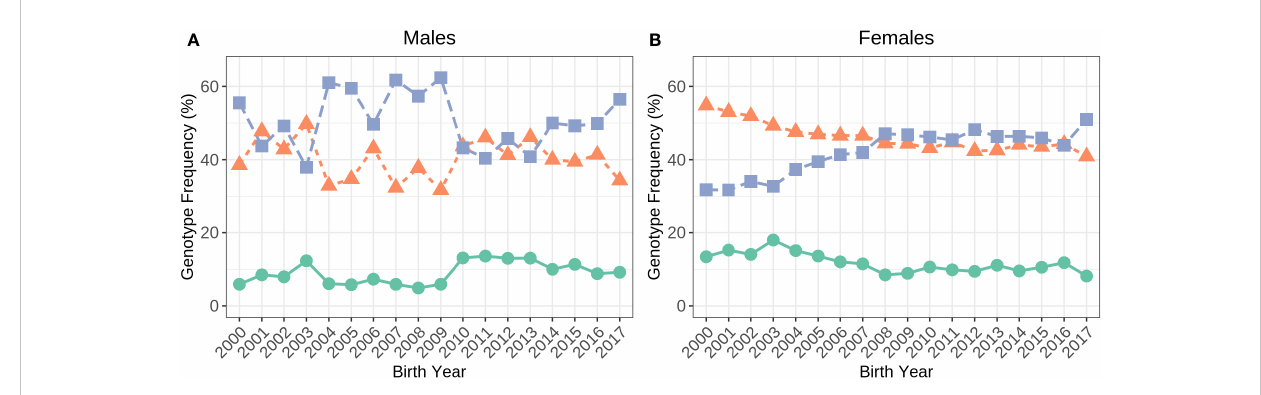
FIGURE 2 Frequency of the A1/A1 (green), A1/A2 (orange) and A2/A2 (purple) genotypes in Holstein males ( A ; N=4,460) and females ( B ; N=69,753) born in 2000 to 2017.